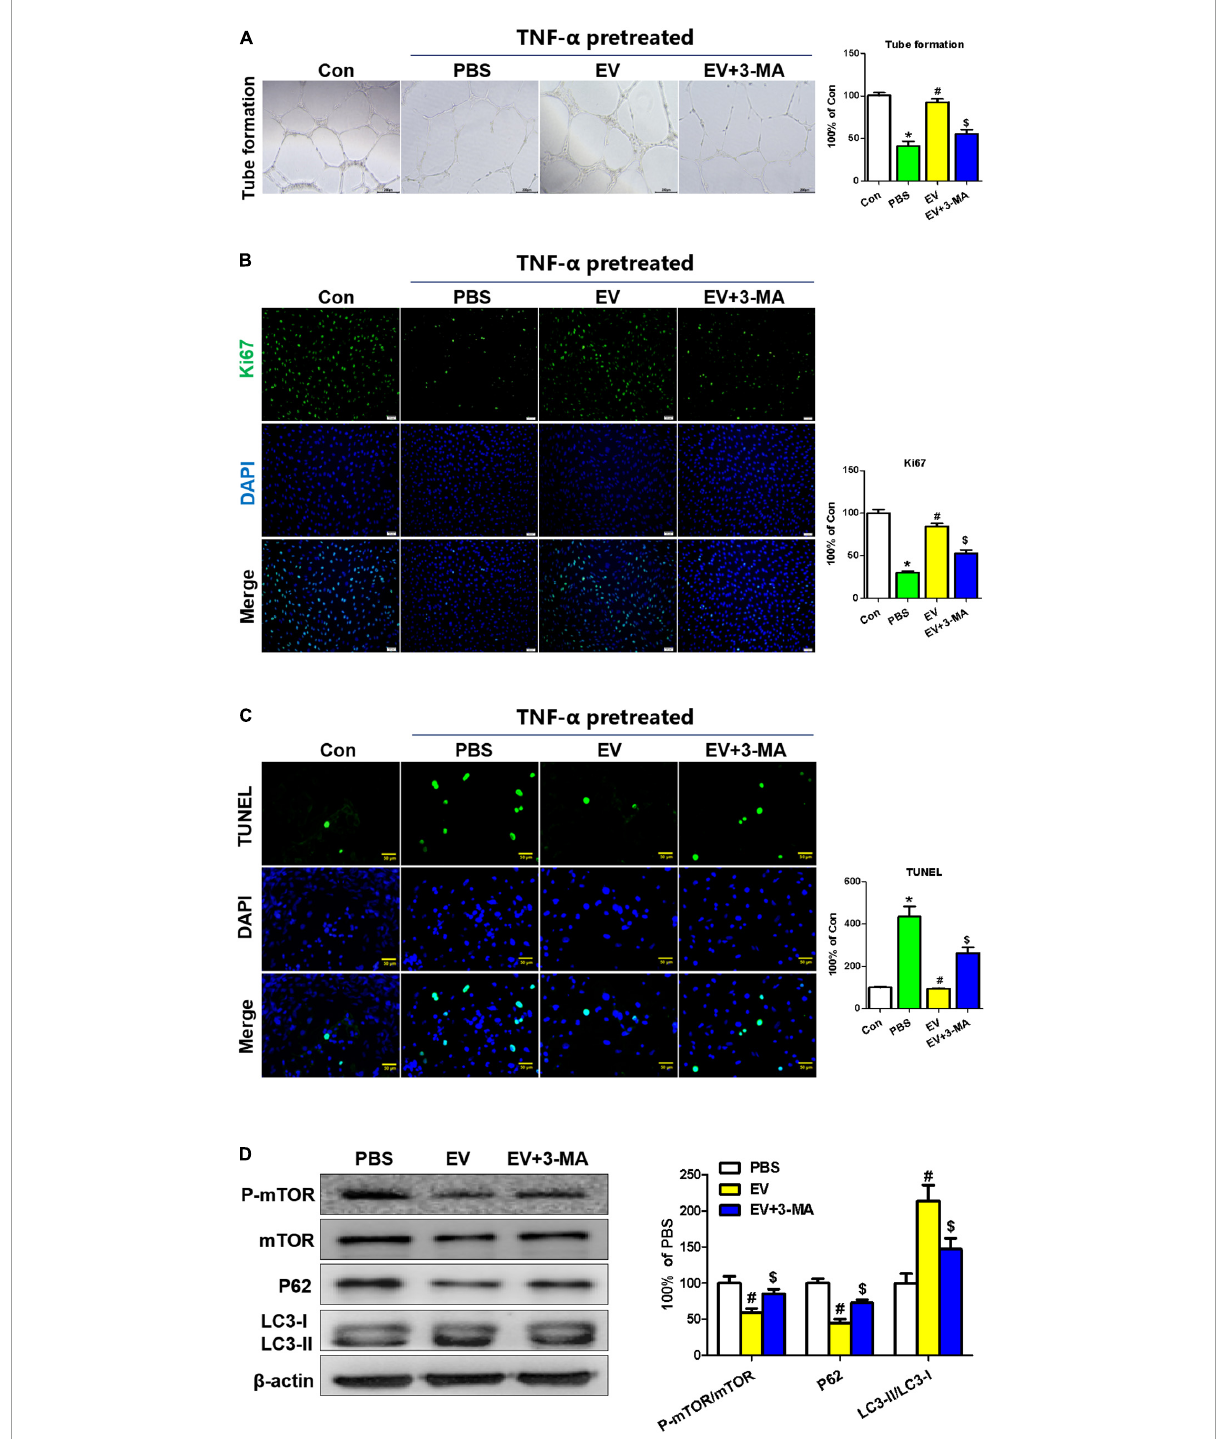
FIGURE5 The protective effect of human-induced pluripotent stem cell- endothelial cell-extracellular vesicle (hiPSC-EC-EV) on TNF- α -damaged human umbilical vein endothelial cells (HUVECs). (A) Representative light microscopy images of the HUVECs in a tube formation assay. (B) Ki67 immunostaining and (C) TUNEL analysis in the HUVECs treated with or without EV and 3-MA in the presence of TNF- α . (D) Western blotting analysis of the autophagy-related protein expression in the HUVECs with different treatments. Data represent mean ± SD from three independent experiments ( n = 3). Differences between linked groups were evaluated by a two-tailed Student’s t -test. * p < 0.05 vs. Con; # p < 0.05 vs. PBS; $ p < 0.05 vs.